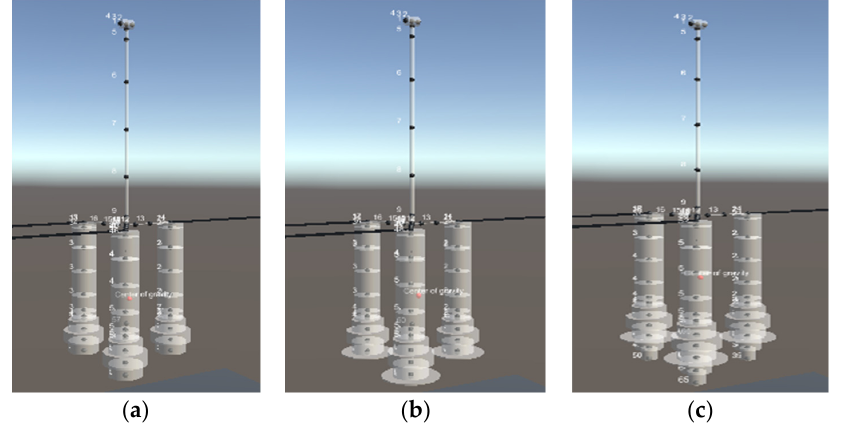
Figure 6. Mesh and nodes considered for each model in the NK ‐ UTWind code analysis: ( a ) Sphere, ( b ) Plate, and ( c ) Semi ‐ Spheroid models.